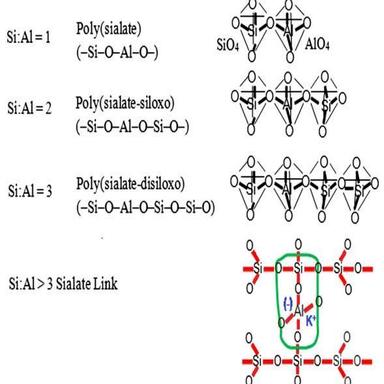
ructure of polysialates